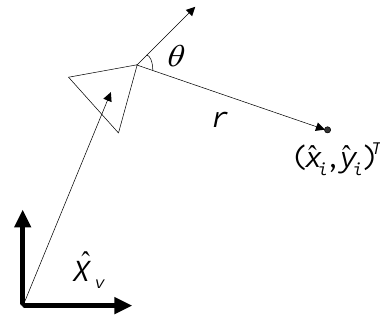
Figure 12. The robot observation model.